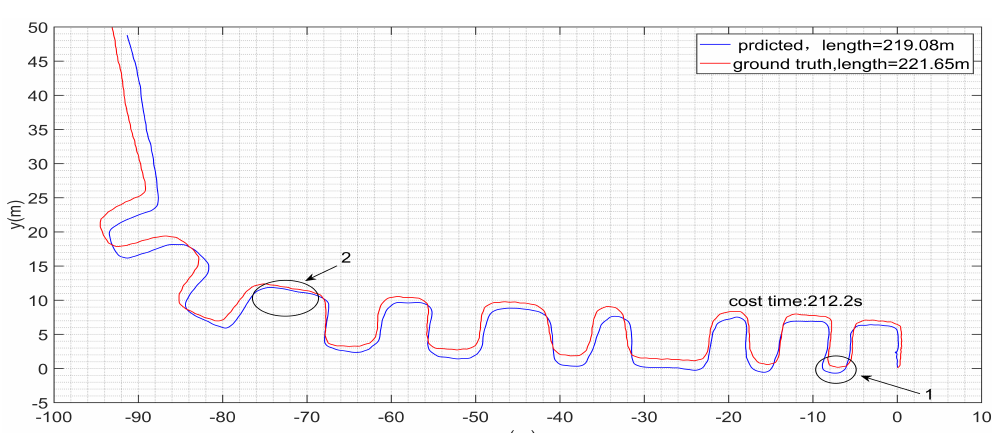
Figure 7. Comparison of the predicted trajectory and the real